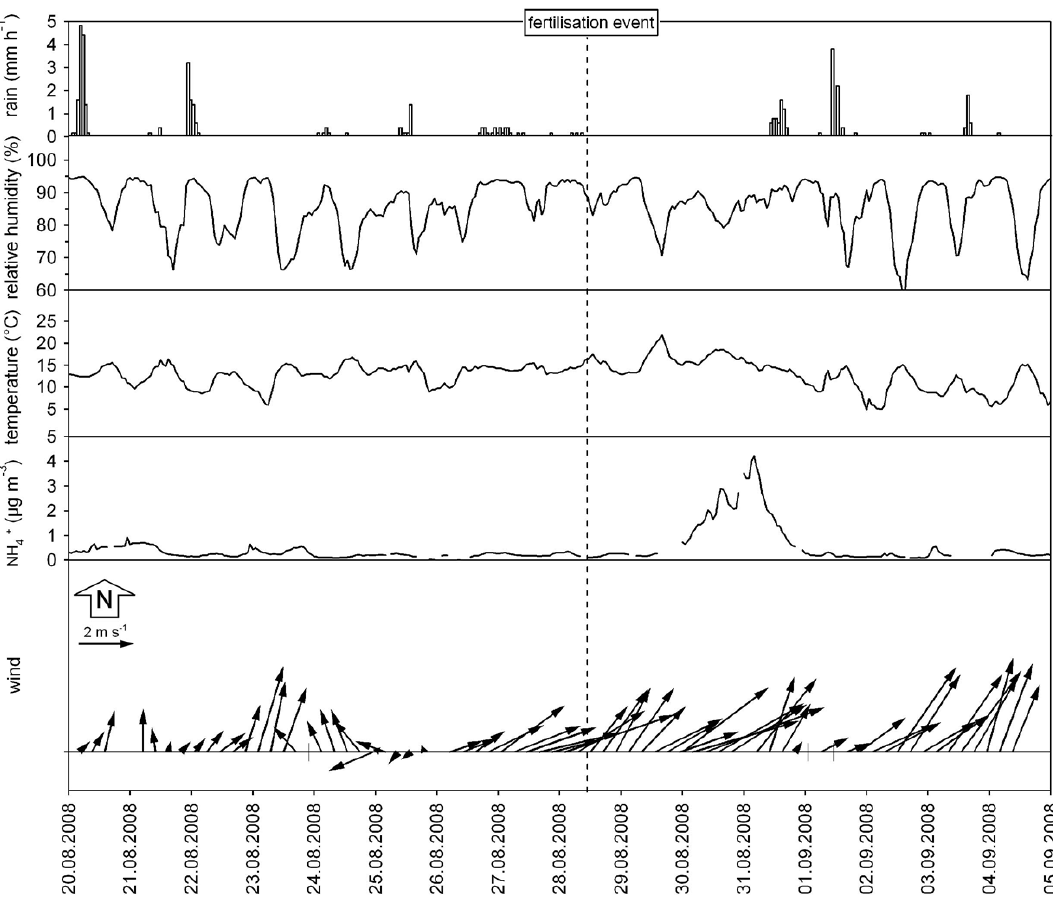
Fig. 2. Time-series of hourly data from selected meteorological variables during the campaign. The aerosol NH + using a MARGA monitor (see text) at the Auchencorth EMEP site, 10km south of the Easter Bush field site. The wind panels show both magnitude and